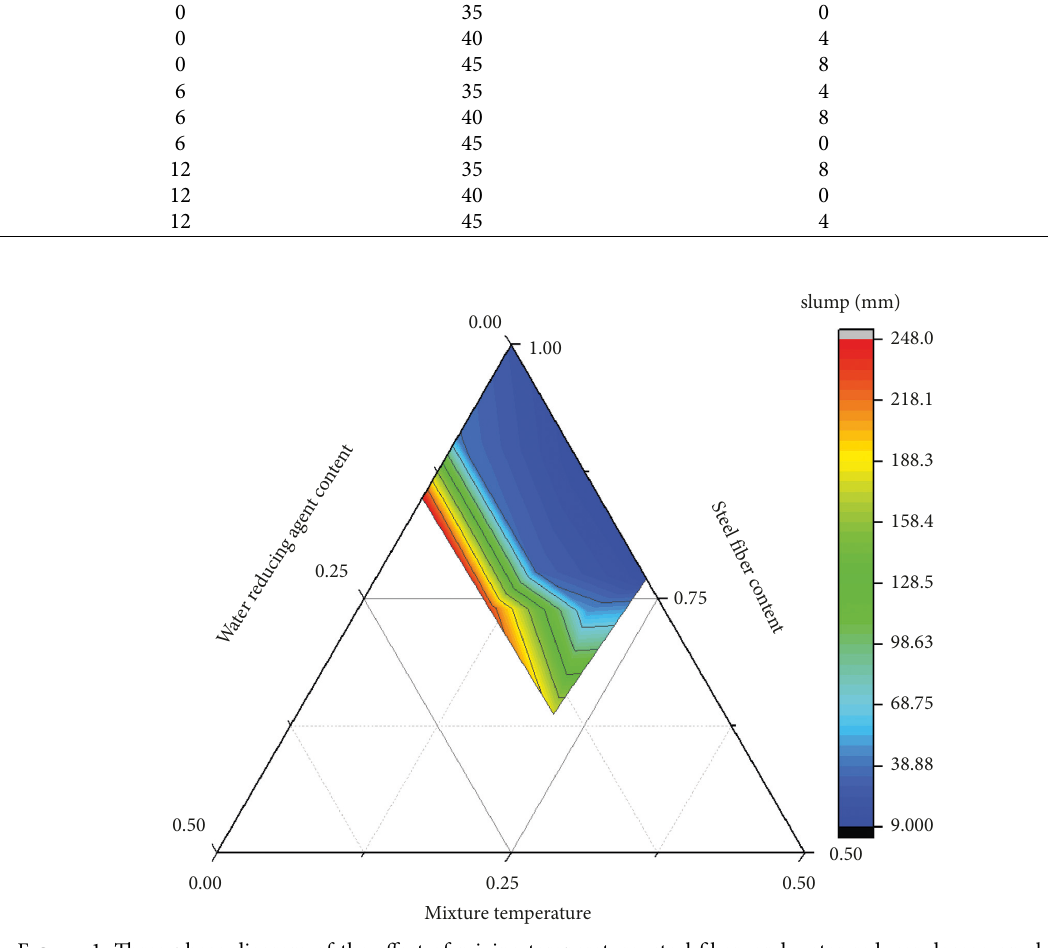
Figure 1: Three-phase diagram of the effect of mixing temperature, steel fiber, and water reducer dosage on slump. Table 2: Visual analysis table of the effect of mixing temperature, steel fiber, and water-reducing agent on slump.